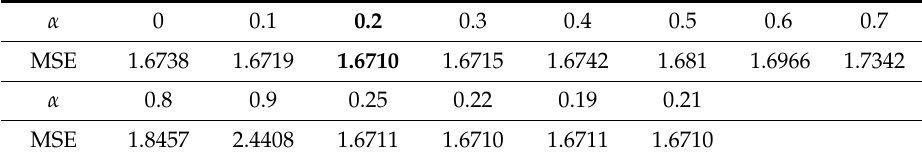
Table 4. Weight selection of Recursive Filter.